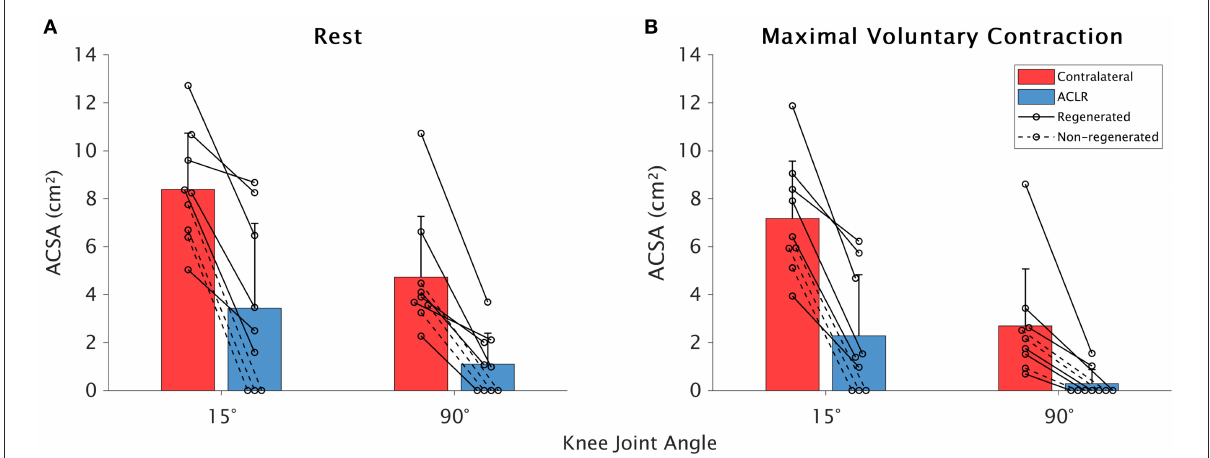
FIGURE2 Means and standard deviations for between-leg differences in the semitendinosus anatomical cross-sectional area (ACSA) at rest (A) and during maximal voluntary contraction (B) in the contralateral (red) and anterior cruciate ligament (ACLR; blue) legs at 15 and 90 ◦ of knee joint flexion. Data from participants whose tendon was regenerated on the ACLR side are shown with a solid line, while those without tendon regeneration are denoted with a dashed